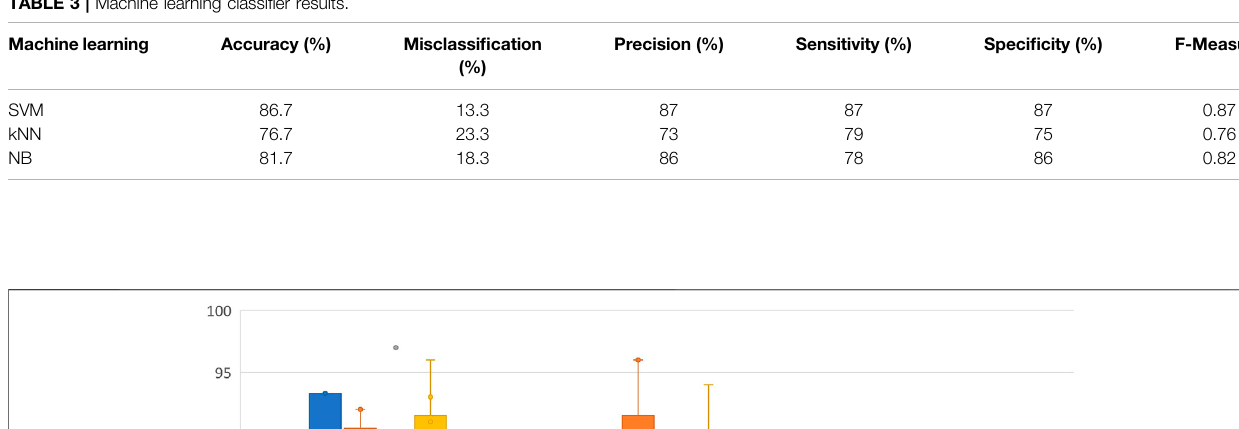
Frontiers in Virtual Reality |